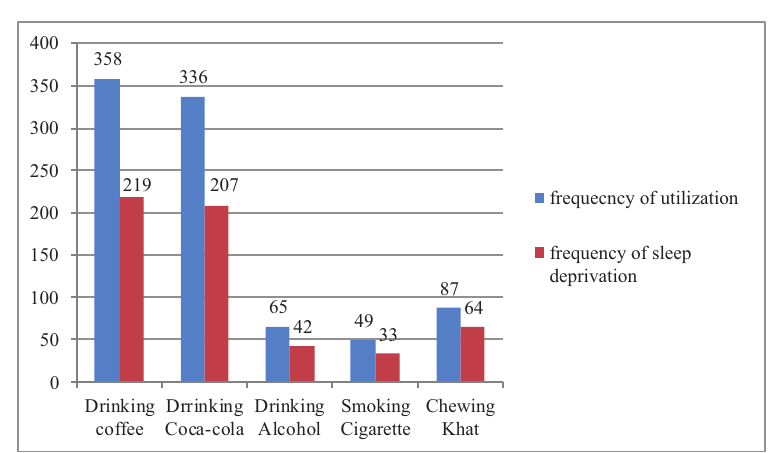
Figure 1. Substance use and sleep deprivation among students of Institute of Health, Jimma University, in 2019.